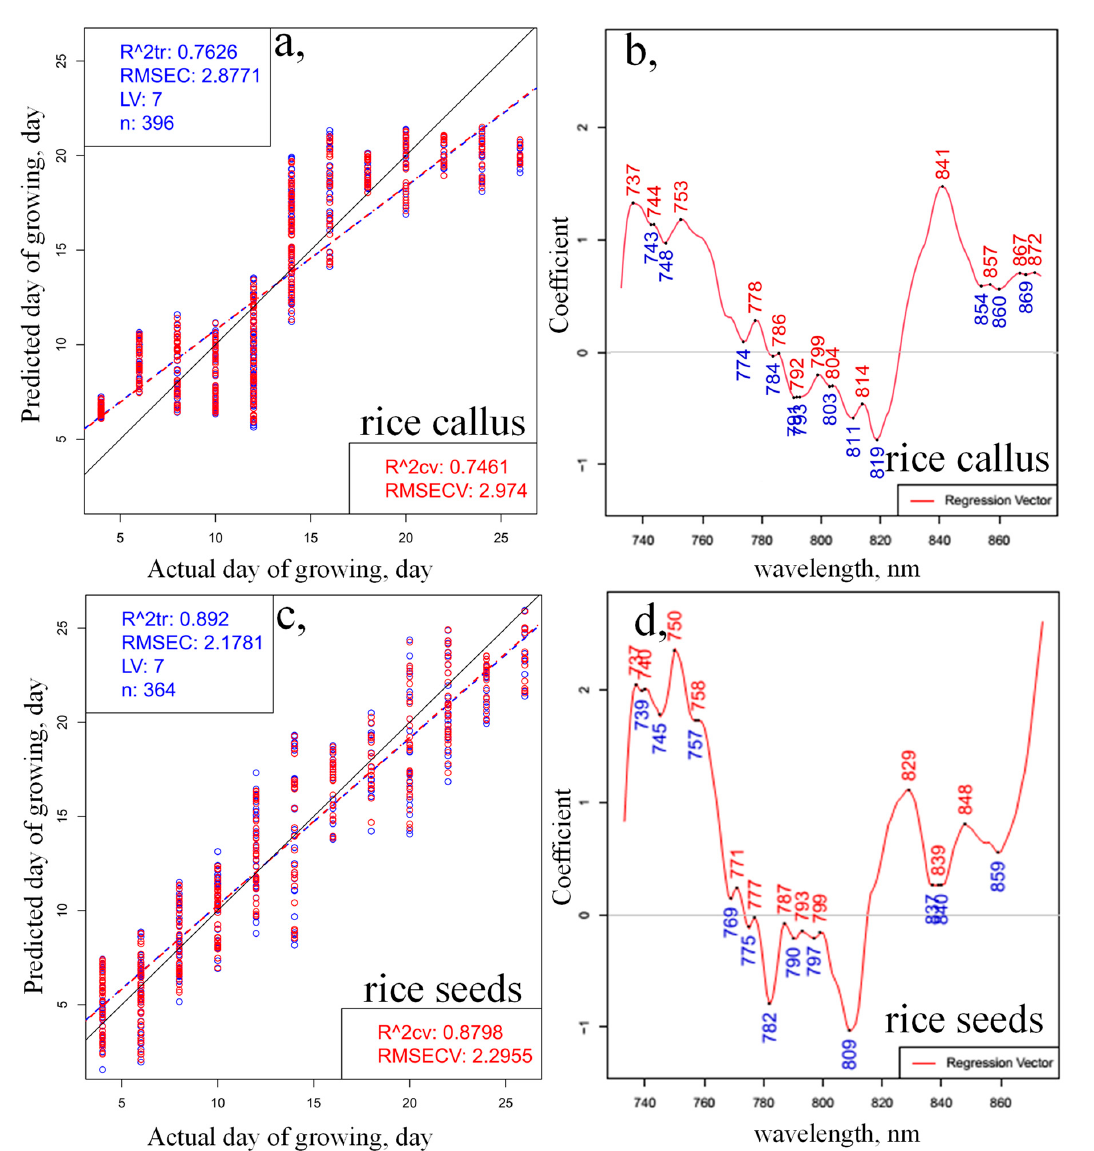
Figure 4. PLSR on the day of growing using the smoothed (calculated with Savitzky-Golay filter using 2nd order polynomial and 31 points), SNV- and linear detrend-corrected transmittance spectra in the spectral range between 730 and 870 nm of ( a ) 28 callus rice seeds and ( c ) 28 somatic rice seeds; regression vector of the PLSR models ( b ) for callus rice seeds and ( d ) for somatic rice seeds (blue circles indicate the calibration and red circles the cross-validation data points; blue dashed lines indicate the calibration Y-fit and red dashed lines the cross-validation Y-fit, while black continuous lines represent the Y-fit of ideal prediction).